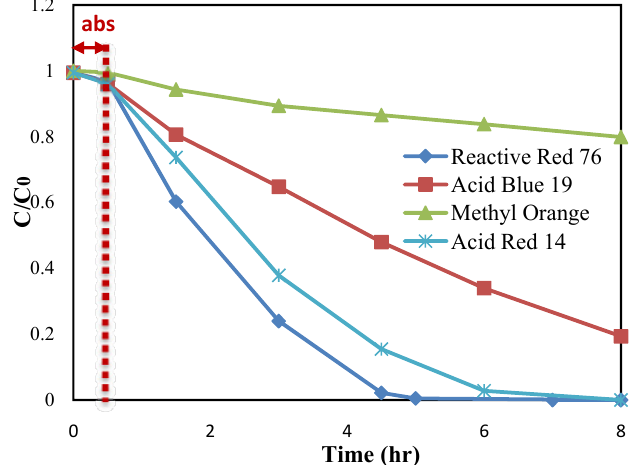
) Nanocomposite dosage = 0.5 g/L, dye concentration = 50 ppm, DO = 7/4 mg/L, pH= 7 (